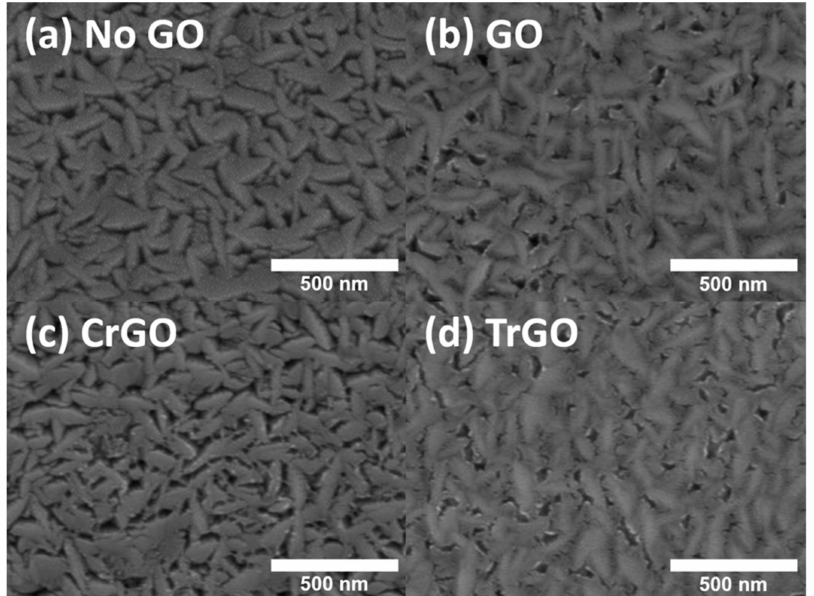
Figure 1. Surface scanning electron microscopy (SEM) images of the Mo back contacts with different intermediate layers: ( a ) no graphene oxide (GO), ( b ) GO, ( c ) chemically reduced GO (CrGO), and ( d ) thermally reduced GO